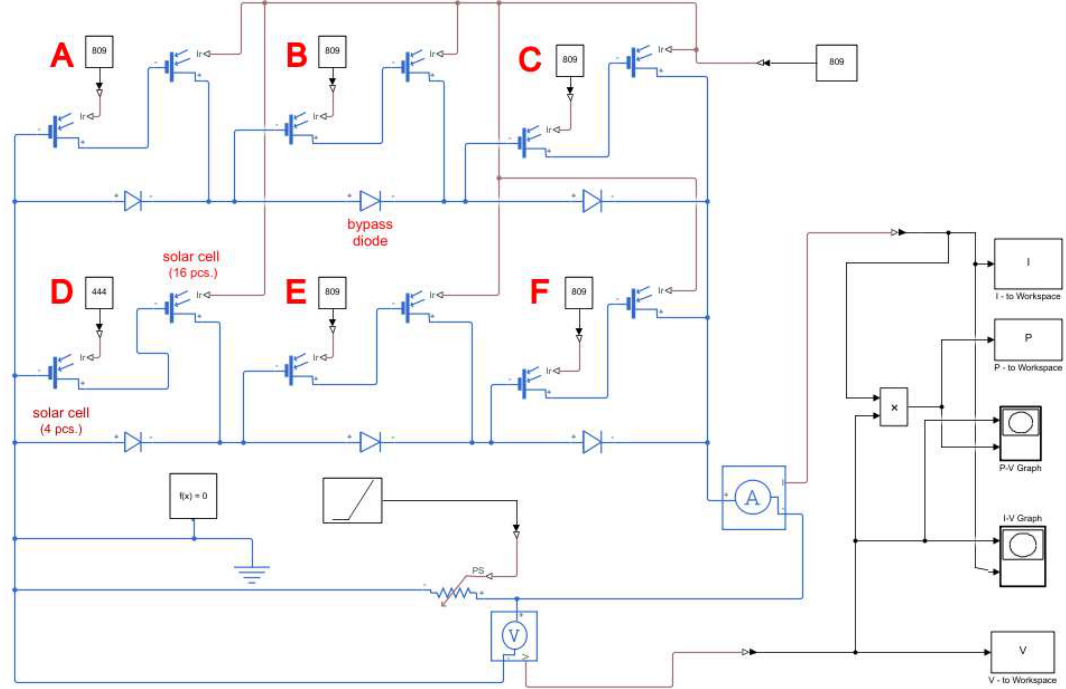
Figure 2. Simulation model of a PV module built from half-cells in the Matlab/Simulink